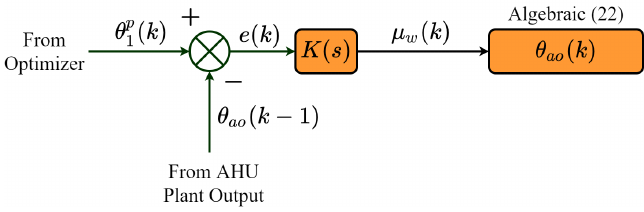
Figure 2. Approximation approach to evaluating Equation